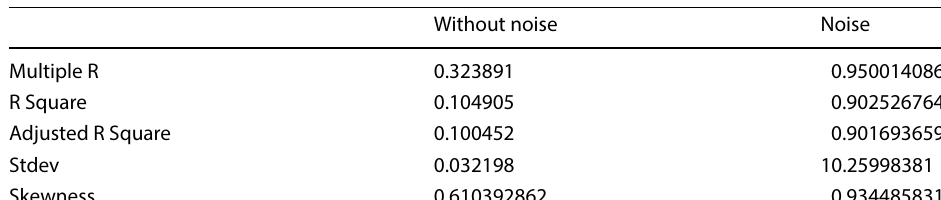
Fig. 13 Positioning Data Anomaly Detection Based on DL